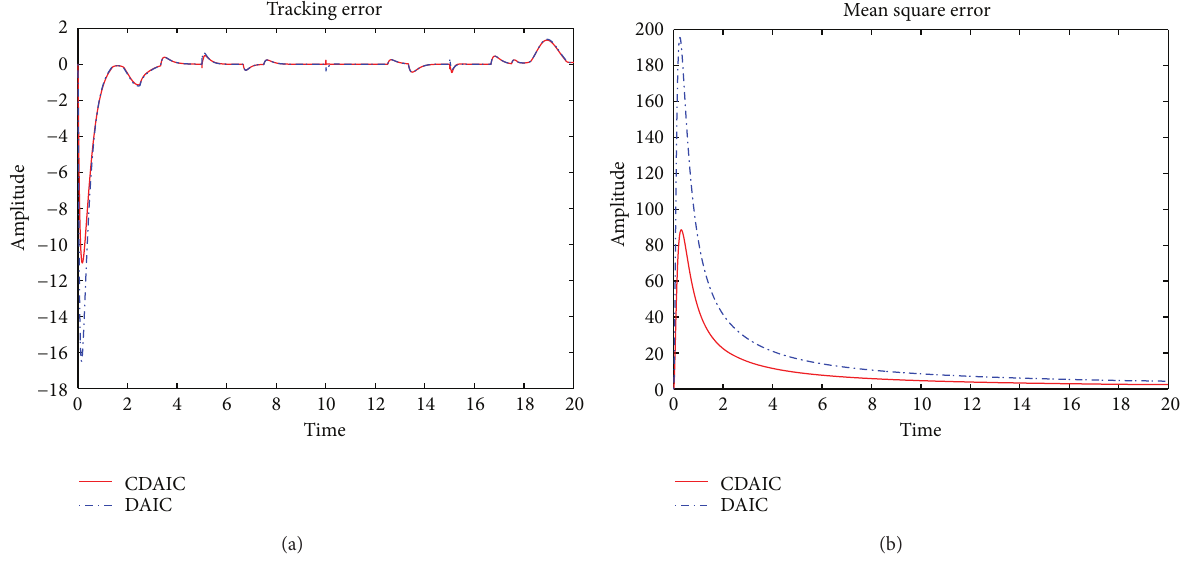
Figure 6: Example 2: simulation results: (a) tracking error; (b) mean square